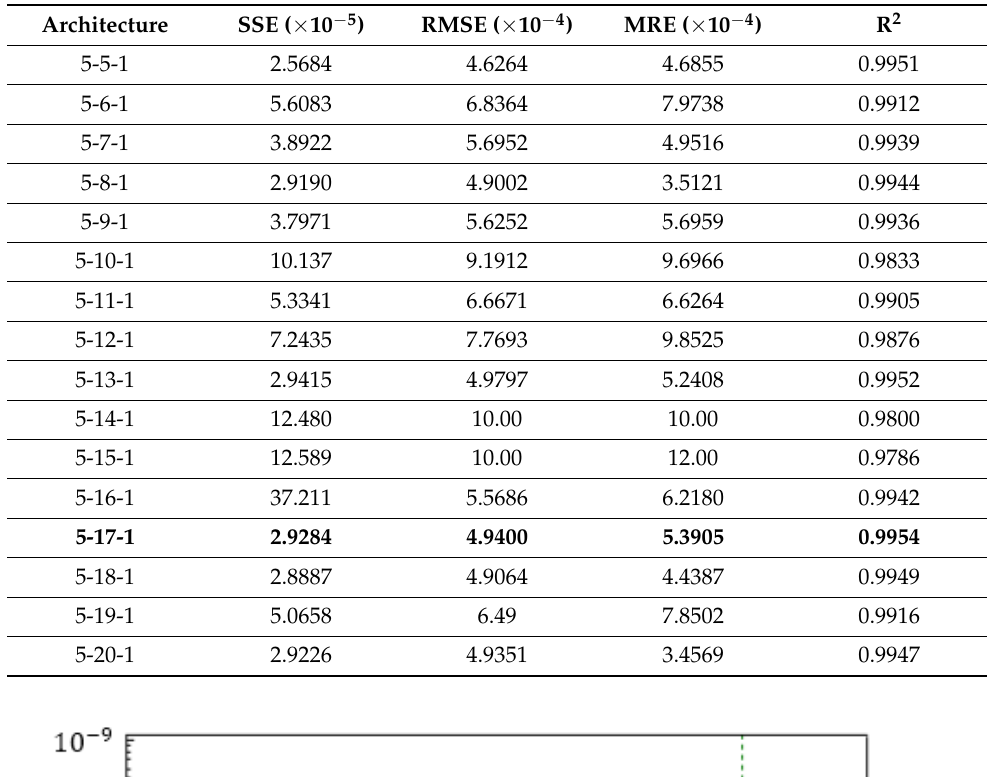
Table 9. Statistical values of main simulated architectures.